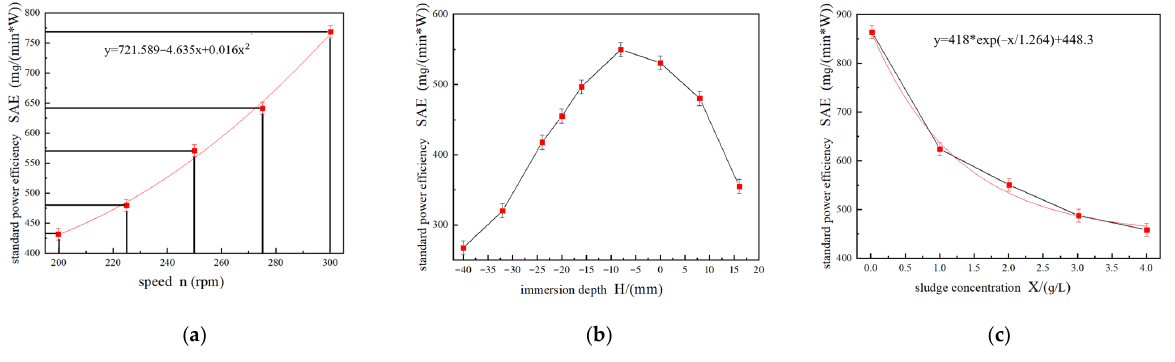
Figure 13. Standard power efficiency: ( a ) at different speeds; ( b ) at different immersion depths; ( c ) at different sludge concentrations.